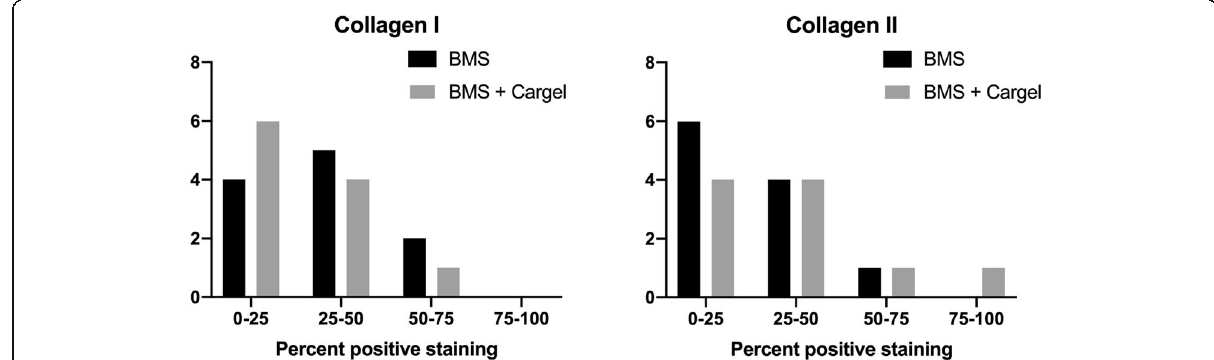
Fig. 7 Graph showing quartiles of positive collagen I (left) and collagen II (right) staining. Grey bar = CARGEL Bioscaffold + BMS, black bar = BMS only. The y-axis represents the number of samples with the quartile of positive staining. In normal hyaline cartilage low amounts of collagen type I and high amounts of collagen type II is seen. BMS = bone marrow